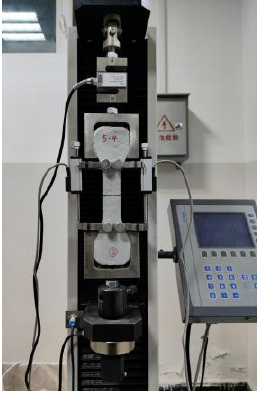
Figure 8. Single-seam cracking tensile test device.